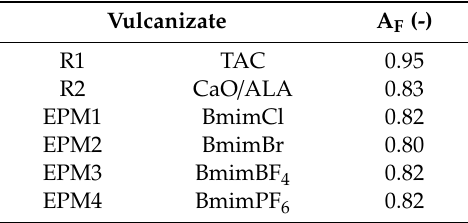
Table 9. Weather aging coe ffi cient (A F ) of silica-filled EPM vulcanizates (standard deviation A F ± 0.04).